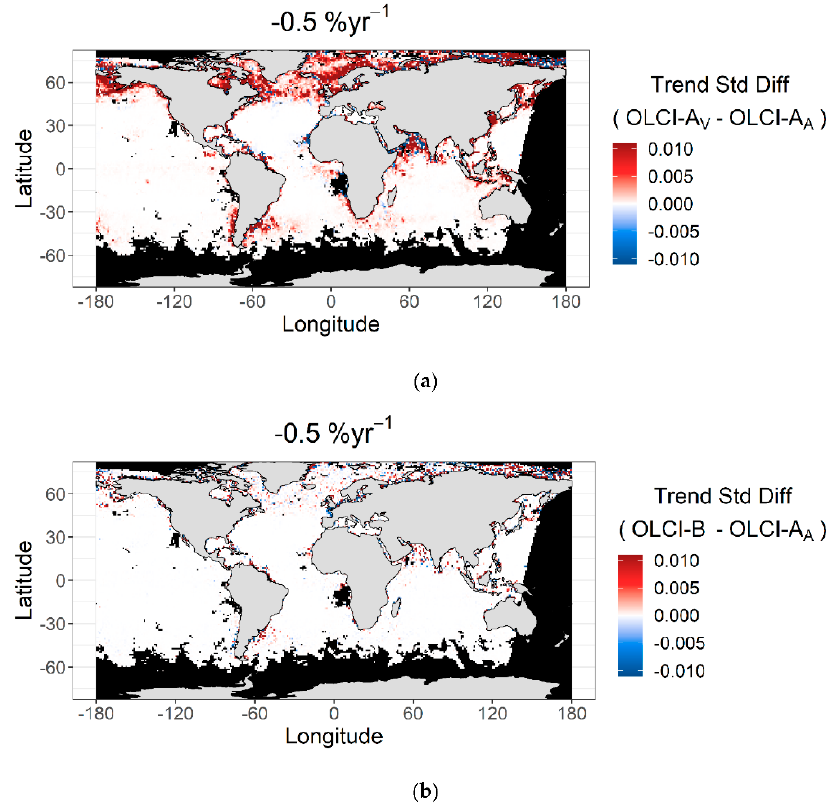
Figure 10. The global map at 1° resolution of the differences between the standard deviation of all trend estimates from all bootstraps for an input trend of − 0.5 % yr − 1 for ( a ) S3A-aligned and S3B, and ( b ) S3A-vicarious and S3B in each grid cell. Red indicates that the latter dataset in each pair has a higher standard deviation of trend estimates than the former dataset in each pair. Reprinted from [24].